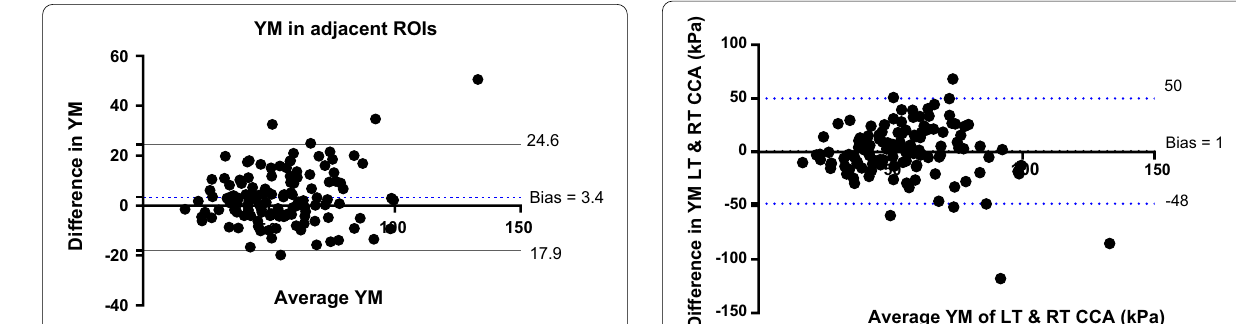
Fig. 2 Bland–Altman plot of the difference between mean YM measurements from the LT and RT CCA of each